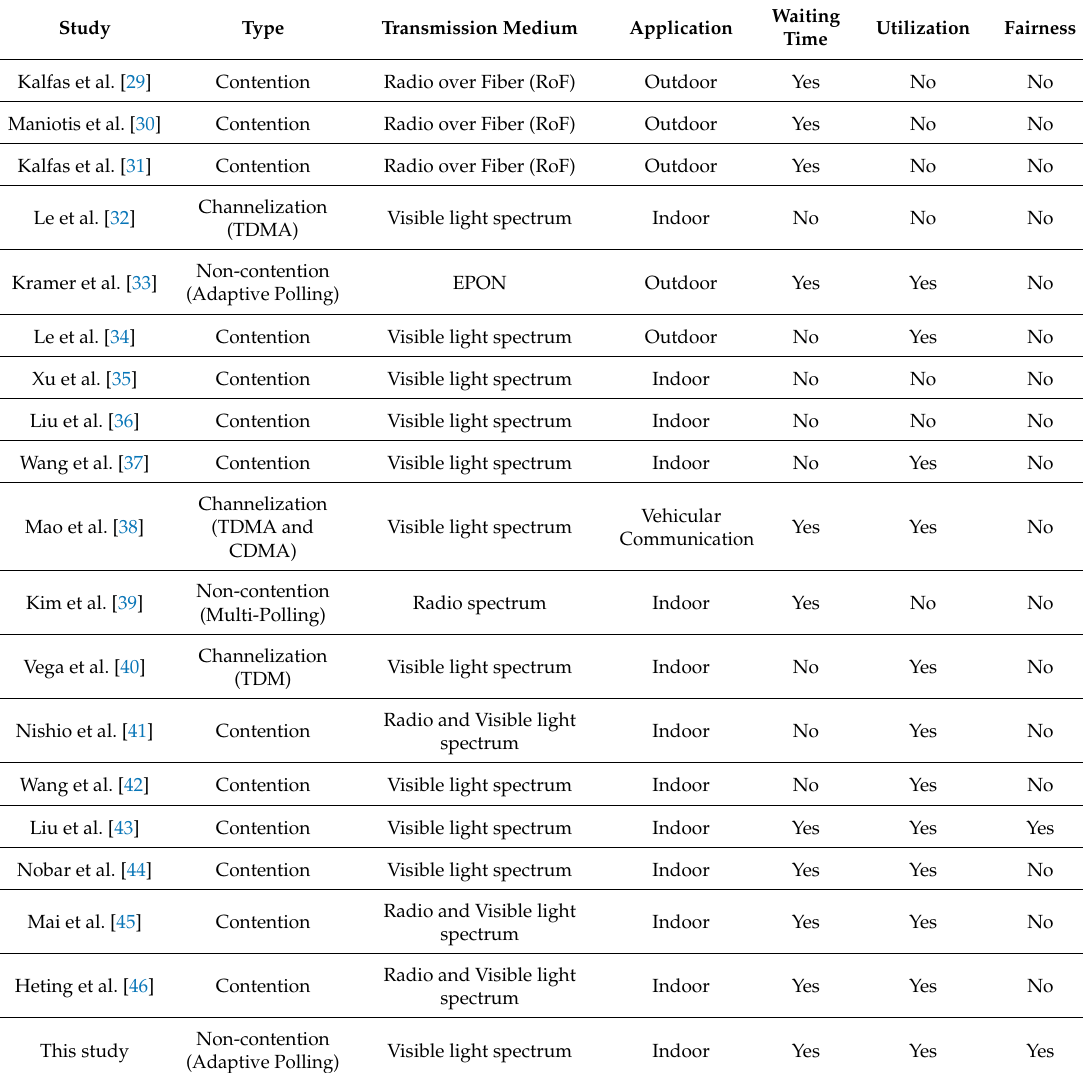
Table 1. Research publications on medium access control (MAC) protocols for optical wireless networks